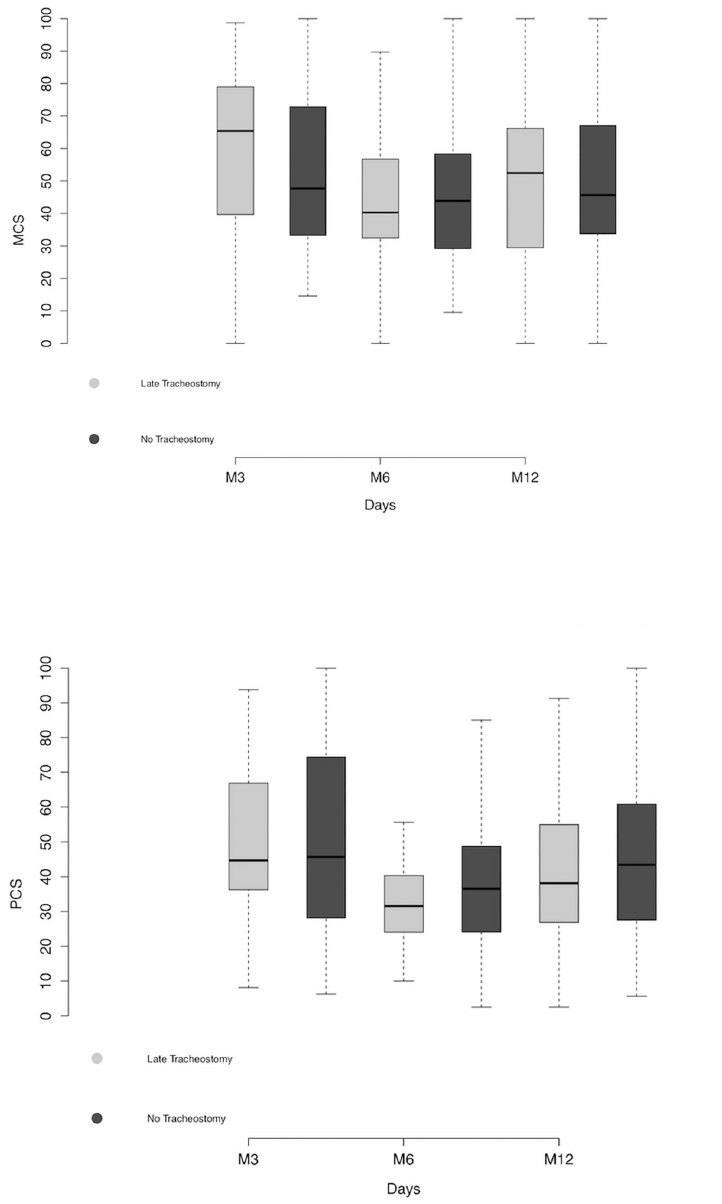
Fig 3. Evolution of the MCS and PCS component of the SF-36 at 3, 6 and 12 months after ICU admission in patients with tracheostomy or no tracheostomy and prolonged mechanical ventilation. The quality of life was measured by the Short Form-36 (SF-36) at 3, 6 and 12 months after ICU admission. SF-36 is a made of a mental (Mental Component Scale, MCS) and of a physical (Physical Component Scale, PCS) component. Each component ranges from 0 (poor quality of life) to 100 (upper quality of life). There is no significant difference in the MCS (Left panel, p = 0.5) and in the PCS (Right panel, p = 0.4) between the two groups. Two-way